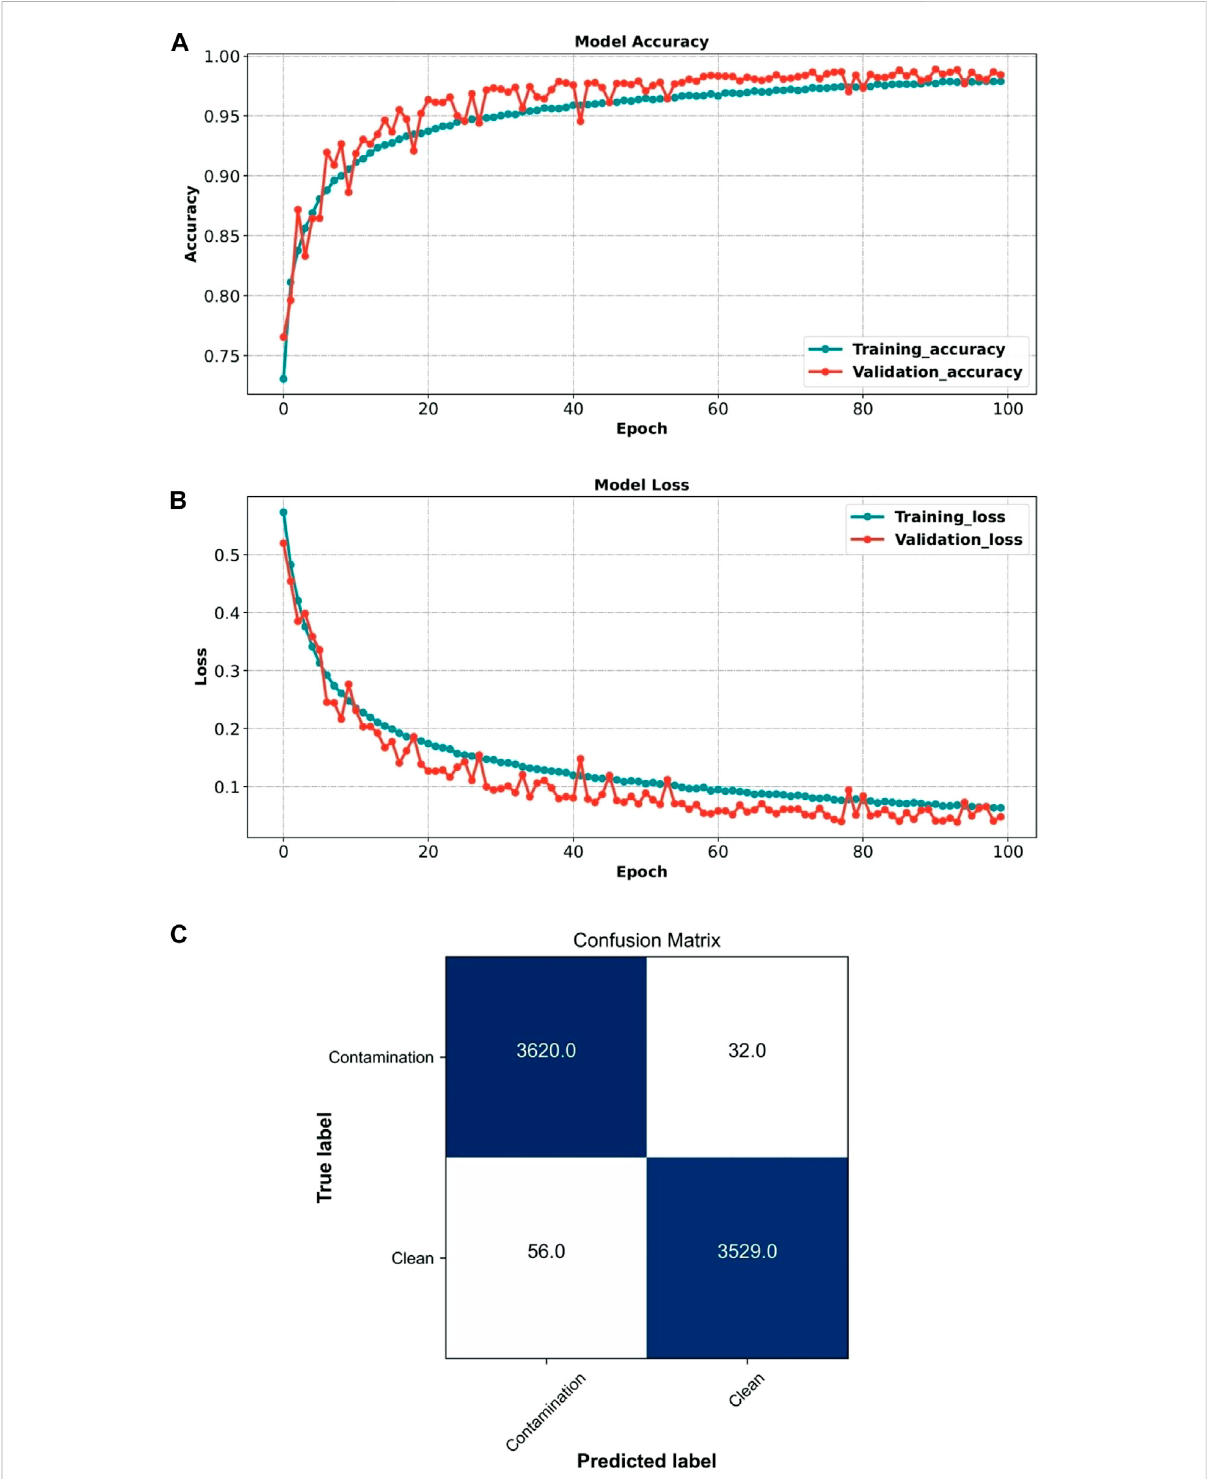
FIGURE 5 Performance of the Xception model (clean vs. contamination frames) (A) Xception model accuracy during training and validation. (B) Xception model loss during training and validation. (C) Xception model confusion matrix when applied to the test set.